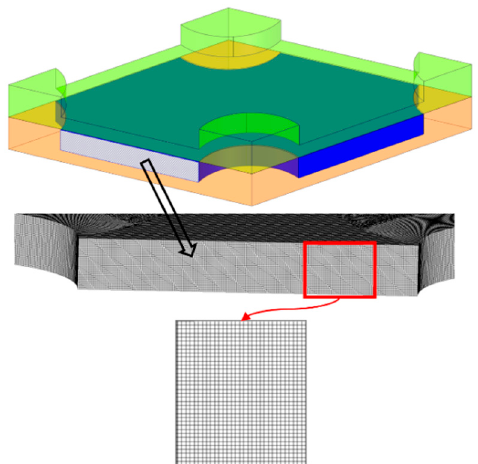
Figure 3. Of the mesh chosen for the final simulations (undeformed domain, P / H = Figure 3. of the mesh chosen for the final simulations (undeformed domain, P/H = 10).